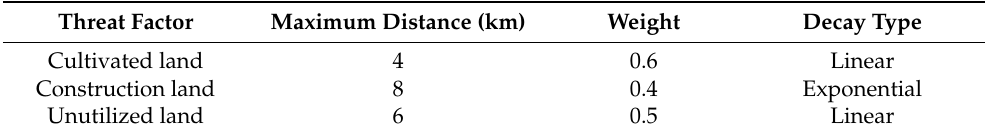
Table 2. Habitat suitability of land-use types and relative sensitivity to various threat factors.